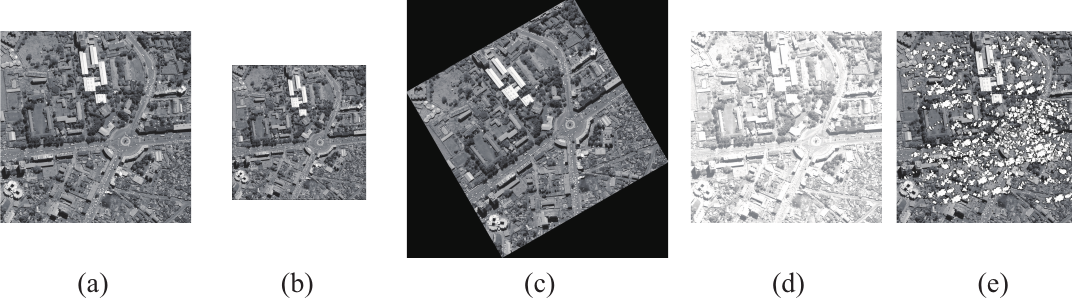
Figure 6. Images with simulated trasformations. ( a ) Original image; ( b ) Scale; ( c ) Rotation; ( d ) Illumination; ( e ) Cloud cover.